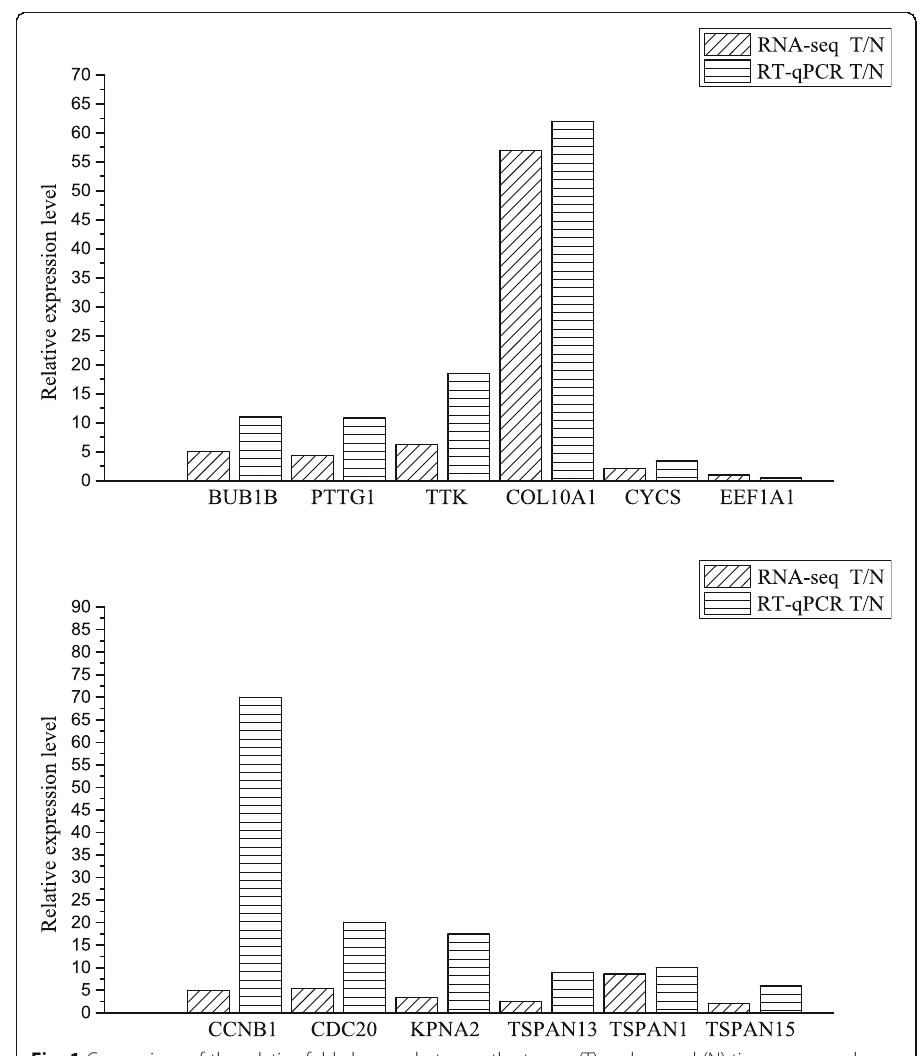
Fig. 1 Comparison of the relative fold changes between the tumor (T) and normal (N) tissues assessed using RNA-seq and quantitative real time PCR results. Fold changes are expressed as the ratios of gene expression in the tumor tissue to that in the normal tissue, normalized to 18S rRNA. T/N indicates the gene expression in the tumor tissue normalized to that for the normal tissue